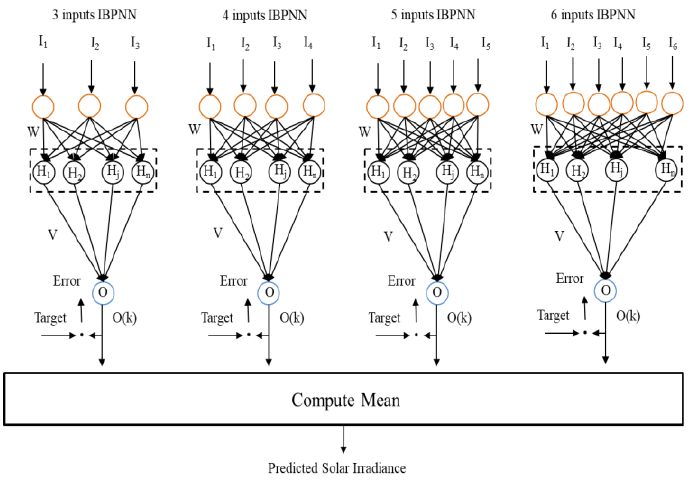
Fig. 1. Proposed EIBPNN